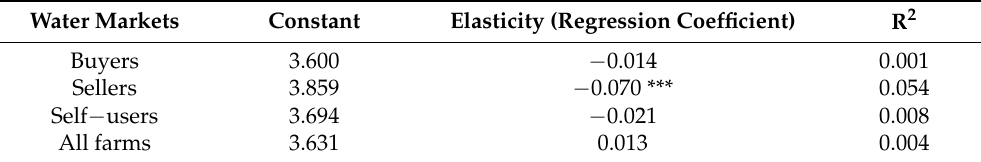
Table 4. The estimated relationship between farm size and wheat yields under different water market regimes.